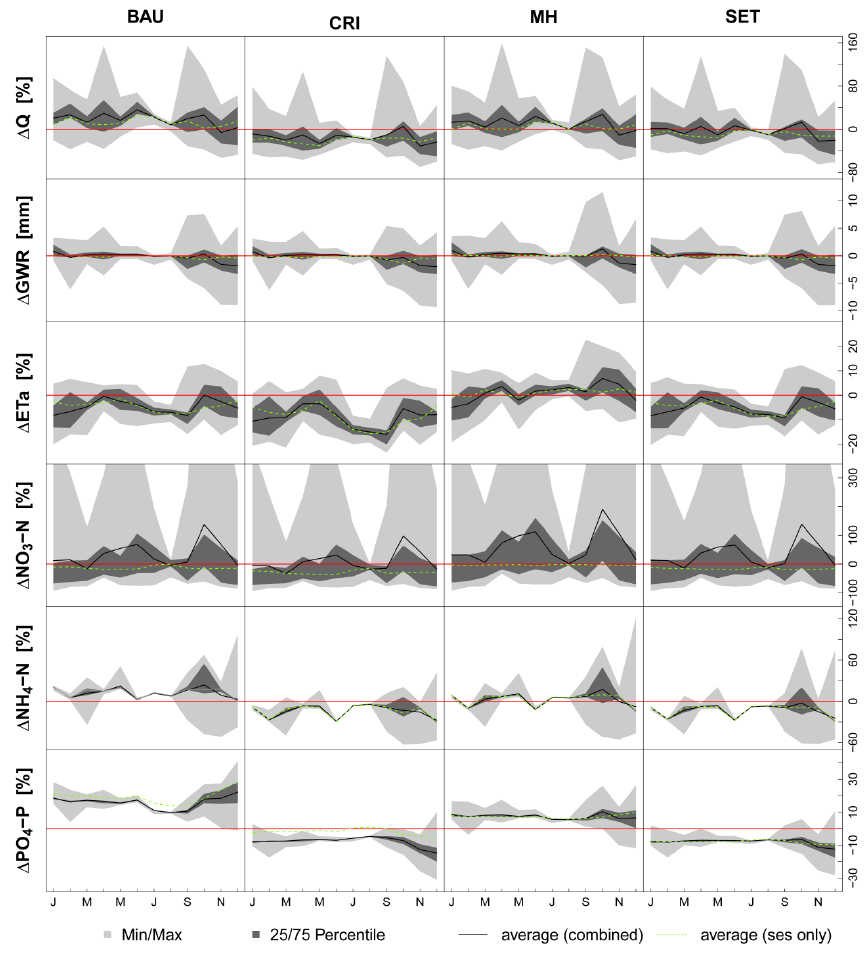
Figure 11. Long-term average monthly impacts of combined climate and socio-economic changes (black line) and of socio-economic changes only (green dashed line) for each of the four socio-economic scenarios (BAU, CRI, MH and SET) on water inflow (Q), groundwater recharge (GWR), actual evapotranspiration (ETa), nitrate nitrogen (NO 3 -N), ammonium nitrogen (NH 4 -N) and phosphate phosphorus (PO 4 -P) shown with uncertainty bands representing the minimum and maximum values (light grey) as well as the 25th and 75th percentiles (dark grey) of the results obtained from 15 climate